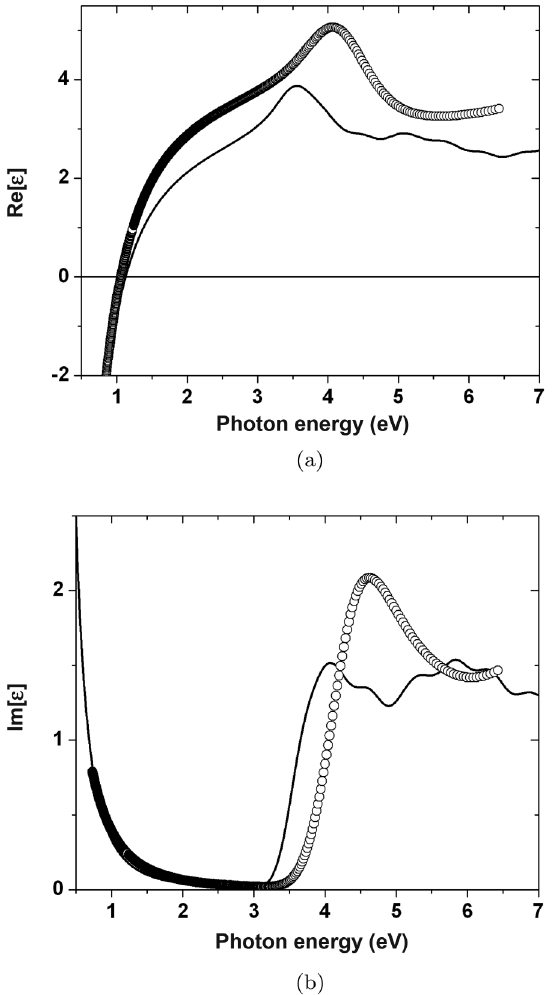
FIG. 8. Real (a) and imaginary (b) parts of the dielectric function spectra of GZO samples calculated (lines) and measured (symbols) for 6